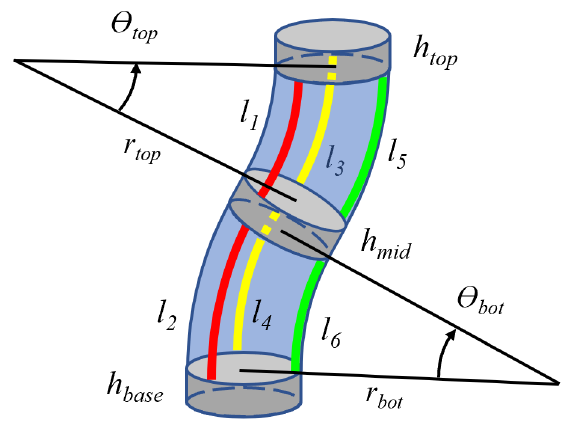
Figure 4. Constant curvature kinematics of the robot module.